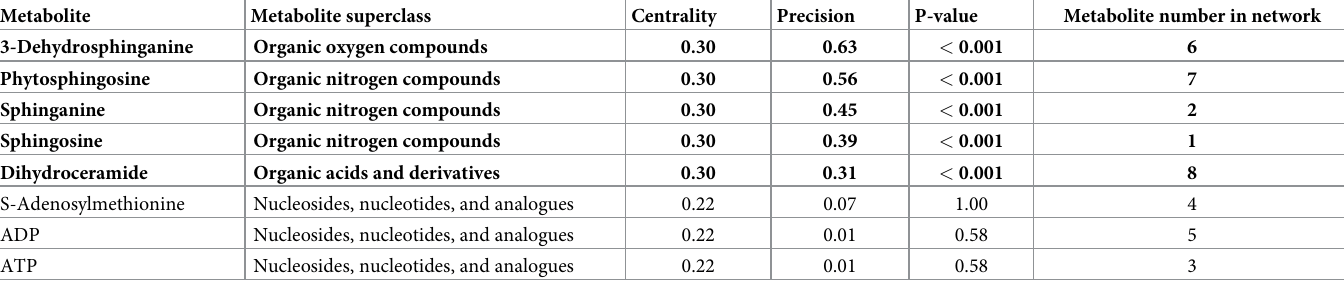
Table 2. Metabolites associated with positive regulation of T cell-mediated immunity. Fisher’s exact test with FDR multiple testing correction was used to calculate p- values, while centrality and precision values are indicators of the importance of the metabolites in this process. The metabolite number in the table corresponds to the num- ber in the interaction network in Fig